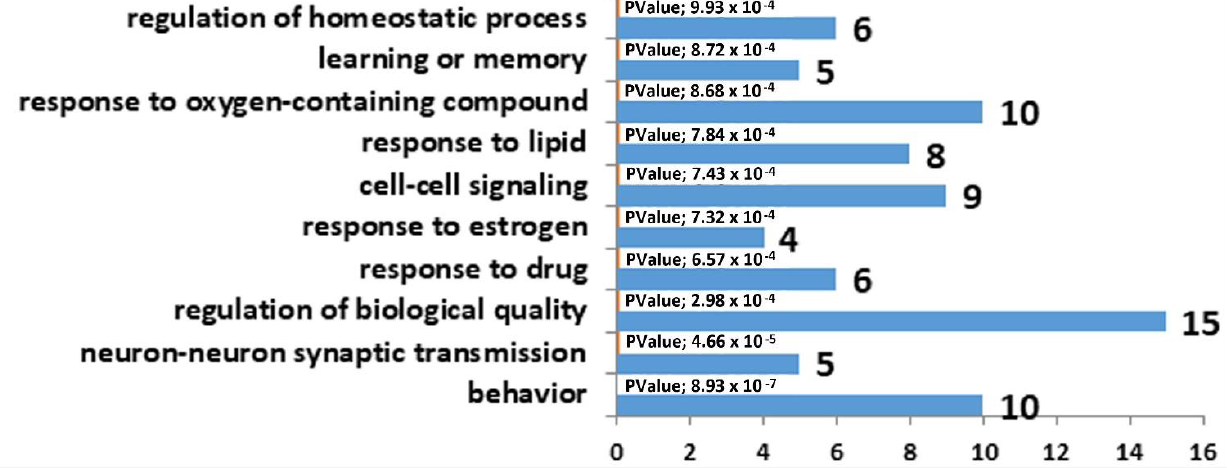
Figure 2. GO terms found to be enriched in the set of DEGs that correlated with Tph2 expression in the MRN transcriptome analysis of the losers. The horizontal axis denotes the number of genes. 4. Discussion We analyzed the impact of chronic social confrontations on levels of gene transcrip- tion in the MRNs of male C57BL/6J mice. It is reported here that, in the MRNs of experi- mental mice, significant changes in the expression of a large number of genes occur both in winners and in defeated males. During the manifestation of the opposite types of social behavior, transcription levels of some genes are expected to change in opposite directions, as shown earlier in the analysis of the VTA transcriptome of the same groups of animals [30]; however, in the MRNs of winners and defeated mice, no genes were found that changed the level of transcription in a direction opposite to that in the opponent group. Furthermore, in the MRNs, numerous genes (158 DEGs) underwent transcription altera- tions that were unidirectional between the winners and defeated animals. The MAPK sig- naling pathway is linked with the regulation of a wide range of cellular processes, includ- ing proliferation, differentiation, apoptosis, and stress responses in both normal and pathological conditions [43]; this signaling cascade was identified here as a common and